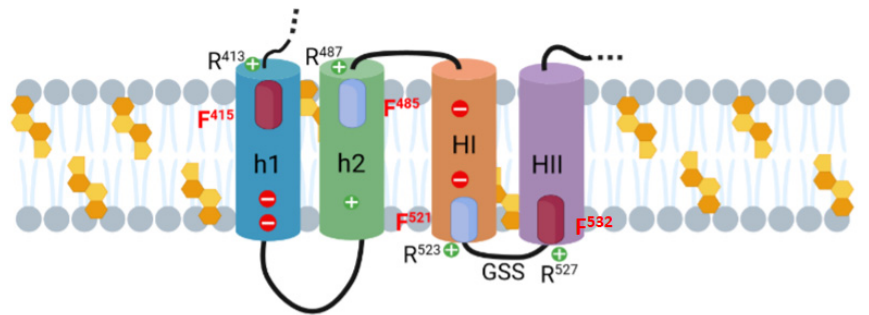
Figure 11. Schematic model of the membrane topology for the h1-h2-HI-HII helices. The figure shows a scheme of the membrane topology for the h1, h2 (TR region) and HI-HII (pore-forming domain) helices as proposed here. Assuming that HI and HII would adopt N out → C in and C out → N in topology, respectively (as explained in the text), then, h2 and h1 topology would be C out → N in and N out → C in , respectively, with the difference that in this case the CARC 415 and CRAC 485 motifs would be facing the extracellular side, and so h1 and h2 would bind cholesterol in the exofacial, side of the membrane. The four cholesterol-binding sites identified in this study, the CRAC 415 and CRAC 532 motifs (purple cylinders) and the CARC 485 and CARC 521 motifs (blue cylinders) and their respective central phenylalanine residues F415, F485, F521 and F532 (in red) are highlighted. Other residues cited in the text, in the Discussion section, have been included. Cholesterol molecules are represented by orange-coloured penta-hexagonal figures. Original picture created with BioRender.com.